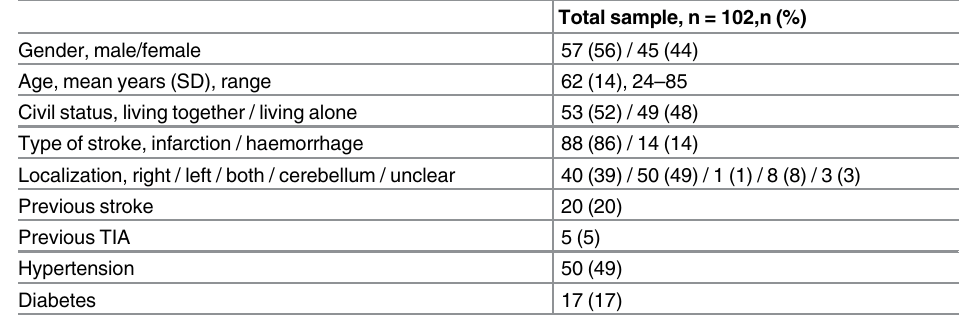
Table 1. Disease-related and socio-demographic characteristics at